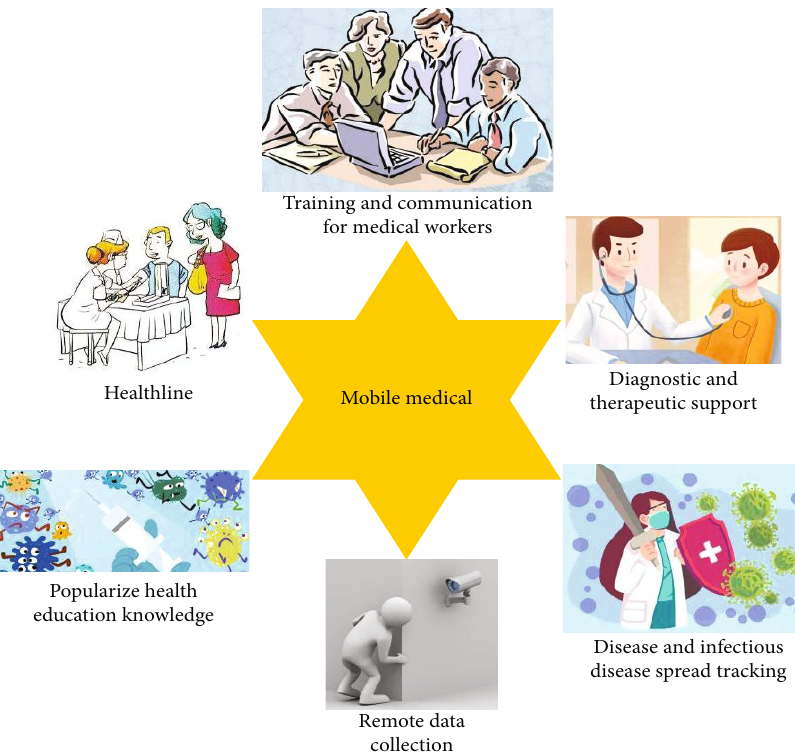
Figure 1: Main application categories of mobile